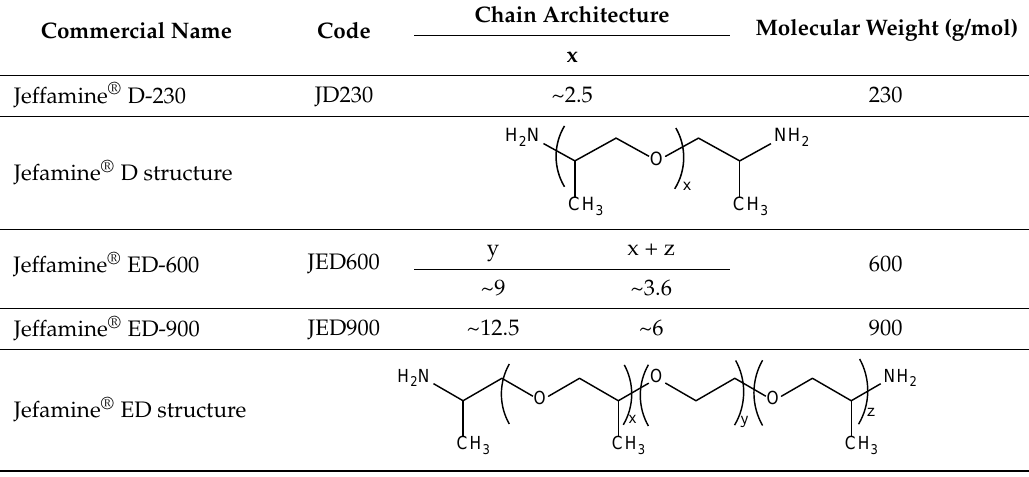
Table 1. Chemical structure, composition, and molecular weights of Jeffamine ® used for polymer synthesis.